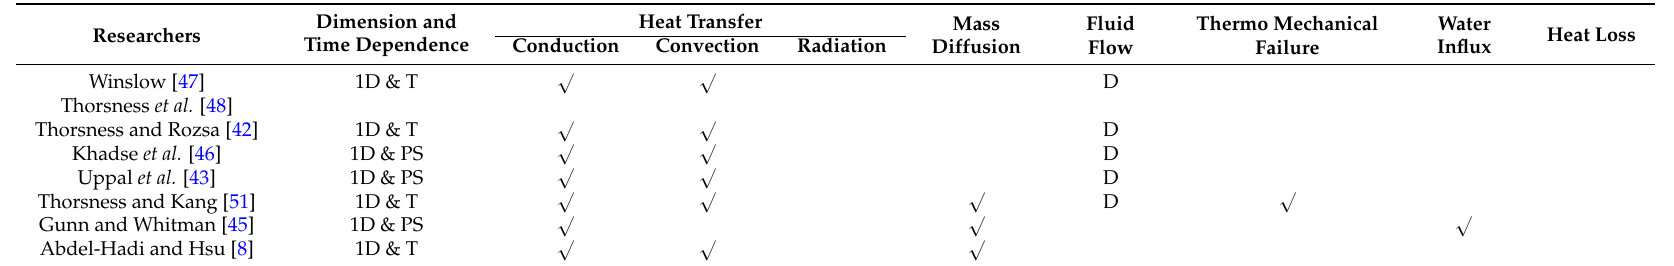
Table 4. Some essential features of reported packed bed models.